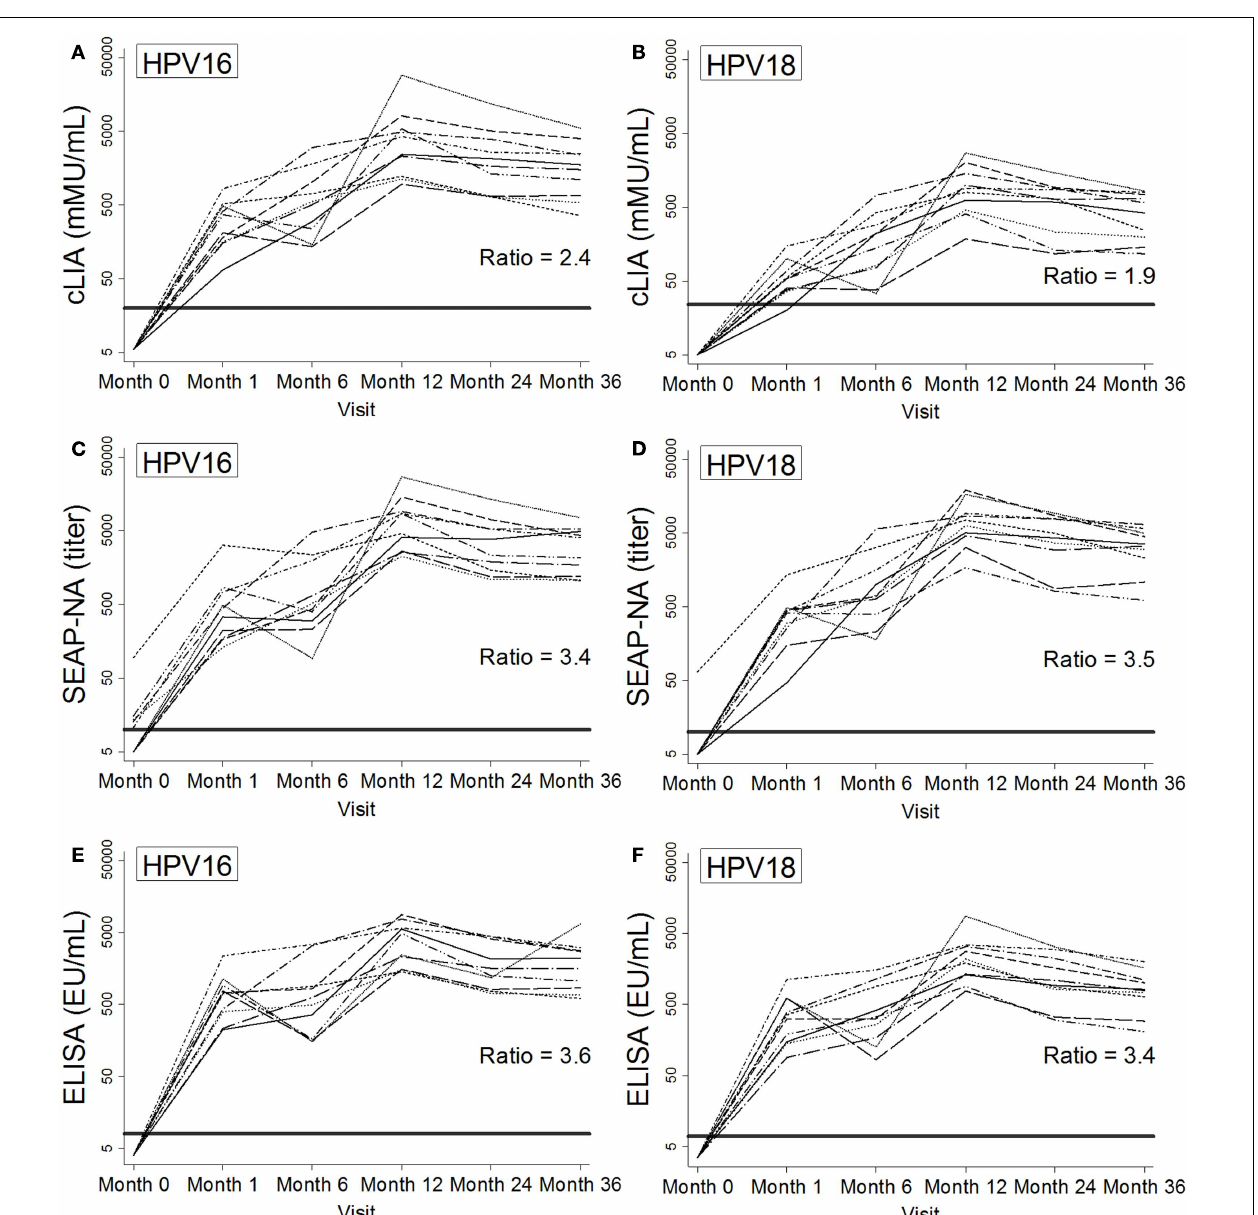
lines represent seropositivity cutoffs, and ratios at 36months were calculated as the mean of log-antibody levels to the log of the